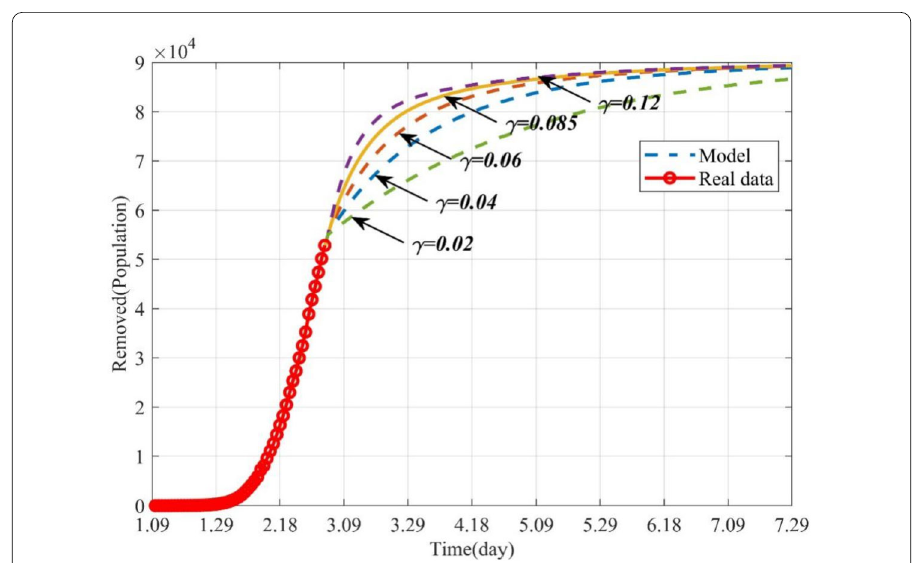
Figure 9 Dynamic trends of the removed with different removal rates ( γ ). The solid line represents the trends of the removed with the current γ . The purple dotted line represents the trends of the removed when γ = 0.12. The orange dotted line represents the trends of the removed when γ = 0.06. The blue dotted line represents the trends of the removed when γ = 0.04. The green dotted line represents the trends of the removed when γ = 0.02